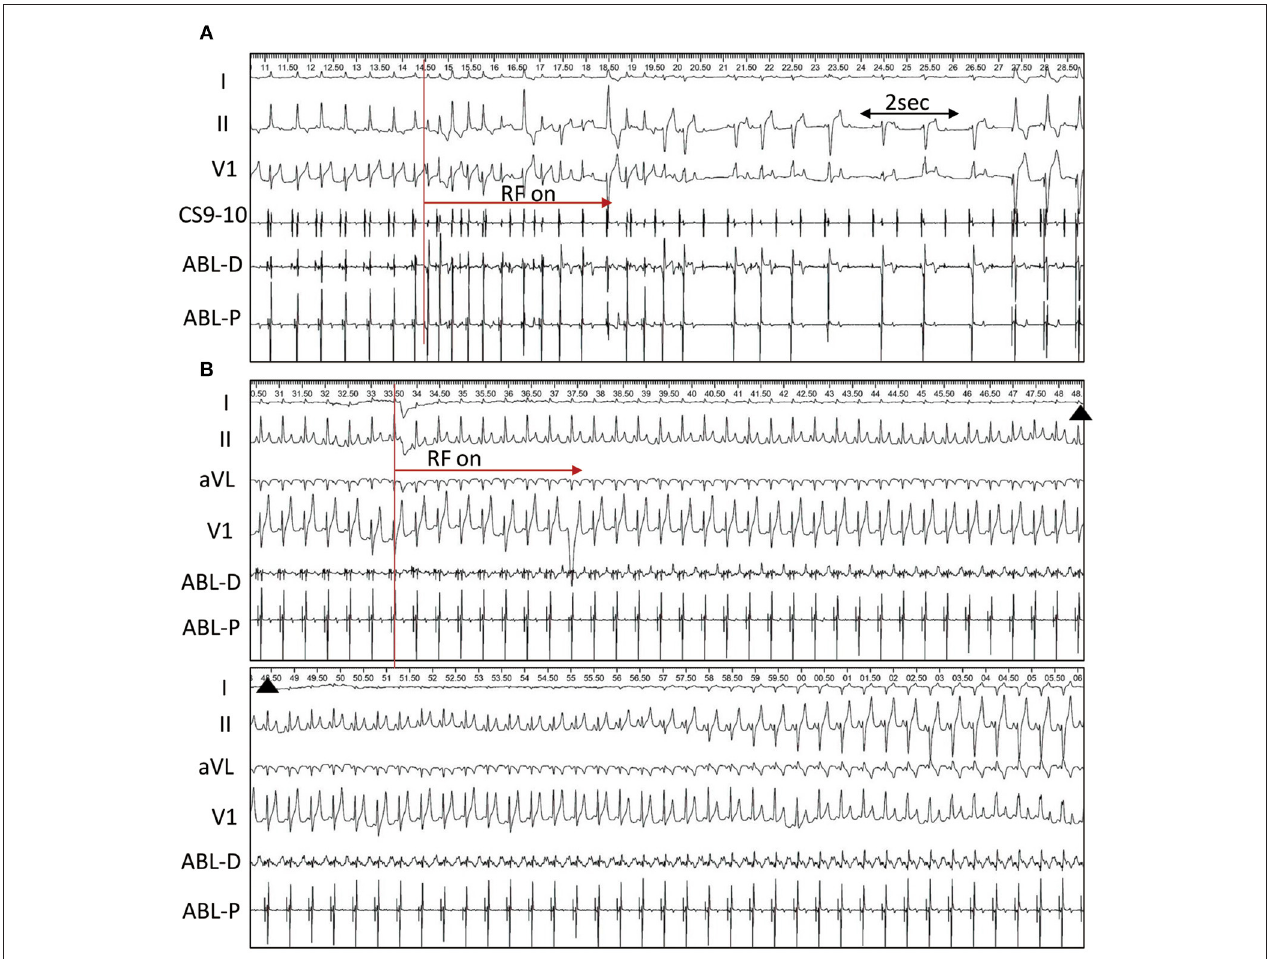
FIGURE 4 | Single RF application at the triangle. (A) Radiofrequency (RF) Ablation in dog #4 (group 1). RF energy delivery results in immediate alternating narrow and wide QRS junctional beats, and complete AVB occurs at 4.4s after ablation followed by ventricular paced rhythm. (B) , Ablation in dog #2 (group 2). Right bundle branch block and left anterior fascicular block occurs 28.8s after ablation and persists until the end of the procedure.